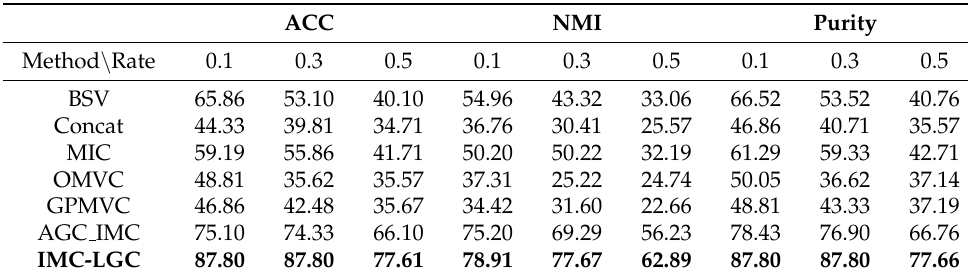
Table 4. Average values of ACC (%), NMI (%), and purity (%) of different methods on the MSRC-v1 dataset with different missing view rates. Bold numbers denote the best results.